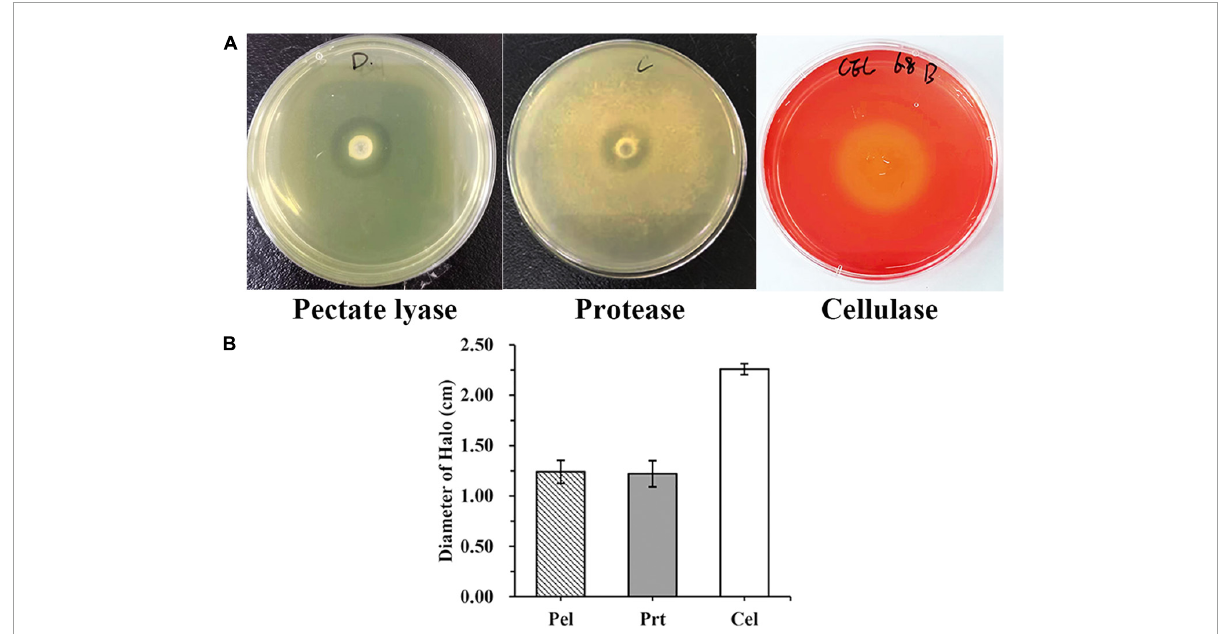
FIGURE4 Extracellular cell wall-degrading enzymes produced by Dickeya zeae strain WH1. (A) Pectate lyase (Pel), Protease (Prt), and Cellulase (Cel) plates; (B) indicates the production of Pel, Prt, and Cel from D. zeae strain